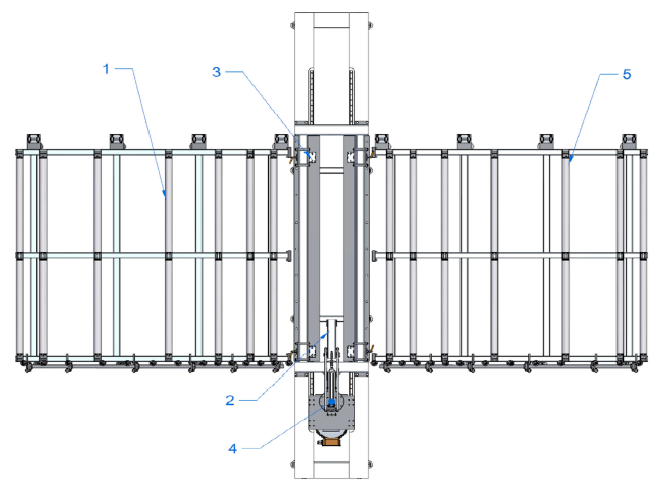
Figure 1. Processing scheme of CLT finger joint mill (1—Assembly table, 2—Removable lock point,